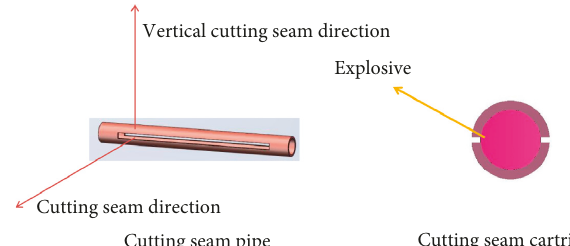
Figure 1: Cutting seam